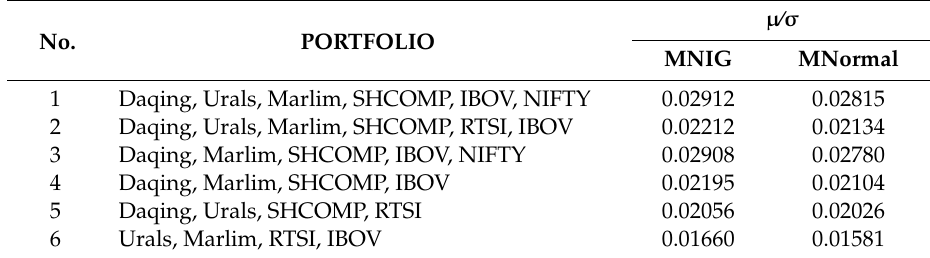
Return–standard deviation relationship for portfolios 1 to 6 using the particular variance-covariance matrix of the adjusted MNIG and MNormal distribution. Elaborated by authors with data from